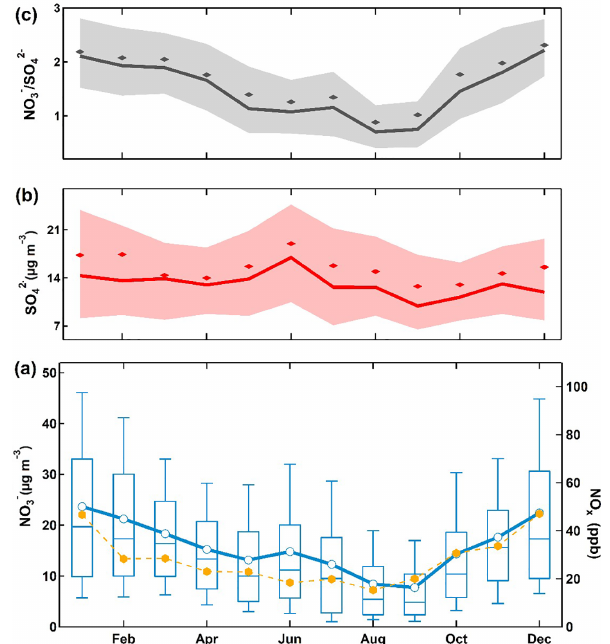
Figure 4. Monthly averaged nitrate (blue), sulfate (red), NO x (or- ange) mass concentrations and nitrate to sulfate molar-based ra- tio (grey) measured at the SORPES station during March 2014 to February 2016. For the nitrate to sulfate ratio (a) and sulfate (b) , bold solid lines are the median values, shaded areas represent per- centiles of 75% and 25% and diamonds represent the mean values. For nitrate (c) , box boundaries represent the interquartile range, bars represent 5%–95% percentile range, horizontal lines represent the median value and crosses represent mean